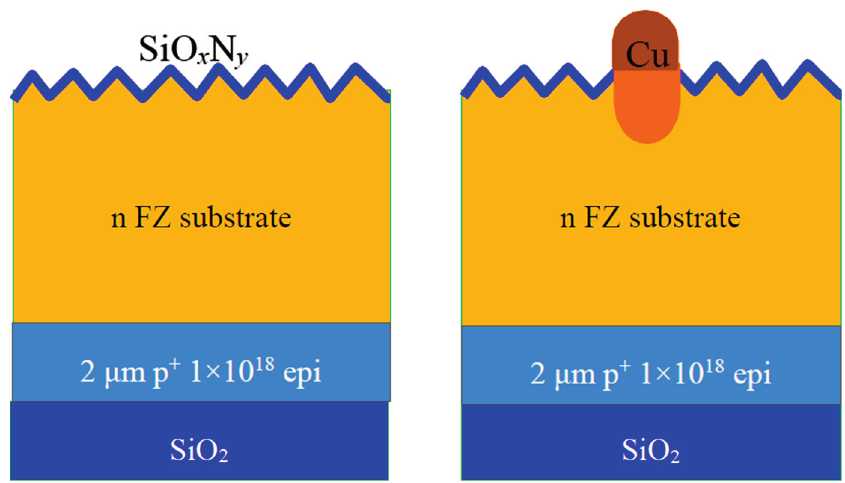
Figure 6. Laser doping on a textured surface, where the front surface is passivated by SiO x N y ( left ) and patterned by laser doping ( right ).